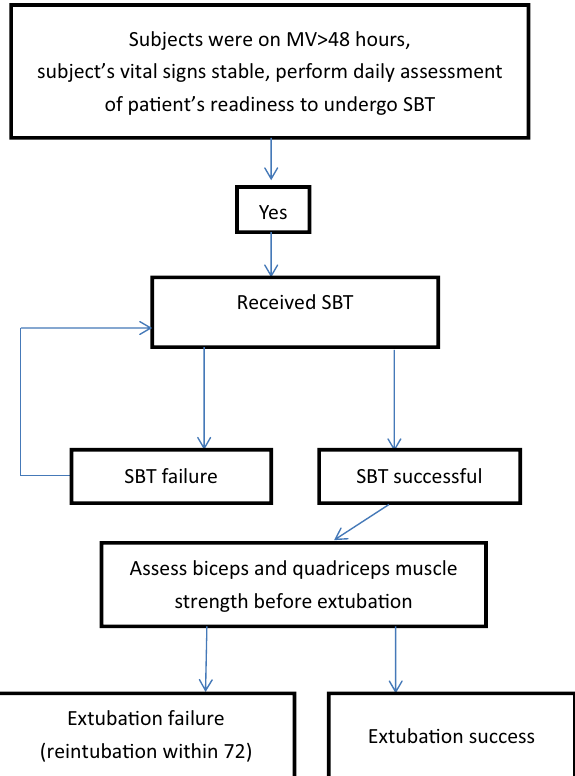
Figure 1. Study flowchart. SBT spontaneous-breathing trial, MV mechanical